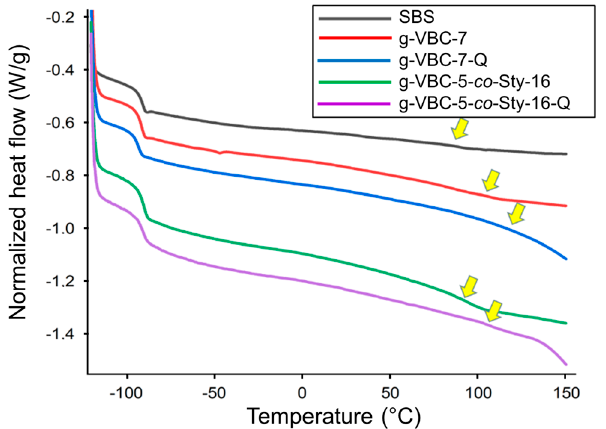
Figure 7. DSC second heating curves (endo down) for SBS, g-VBC-7, g-VBC-7-Q, g-VBC-5- co -Sty-16, and g-VBC-5- co -Sty-16-Q.